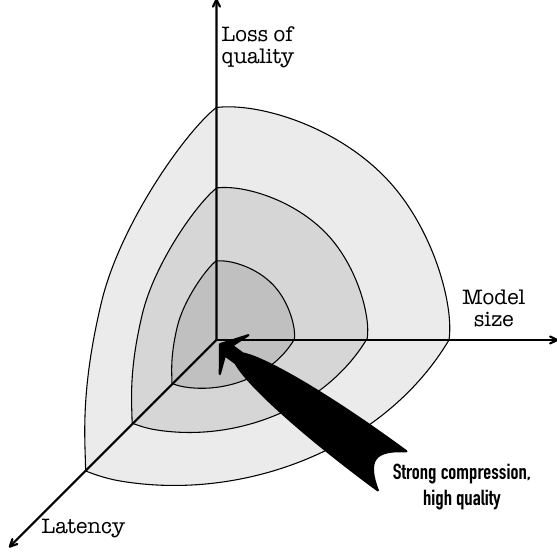
Figure 2. Constrains and demands for Deep Learning models